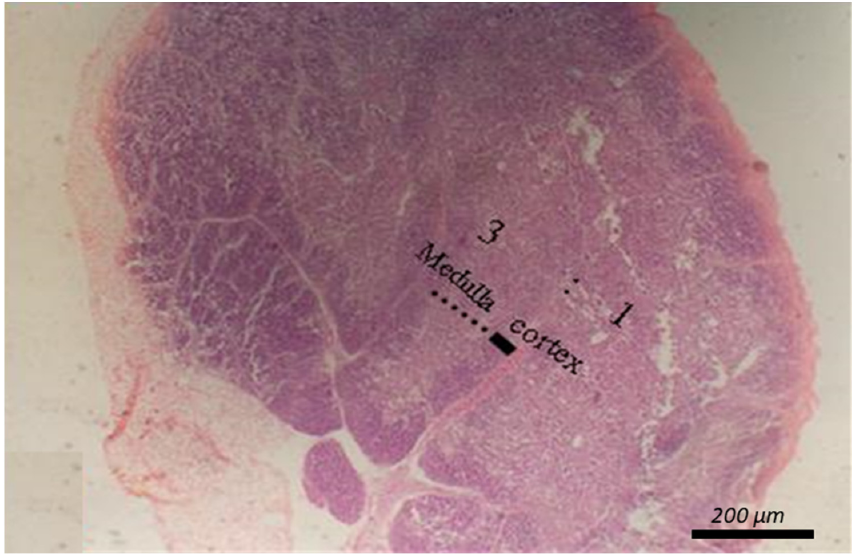
Figure 2. Micrograph of the thymus stained with HandE (X40) to explore the thymic cortical: medullary ratio.